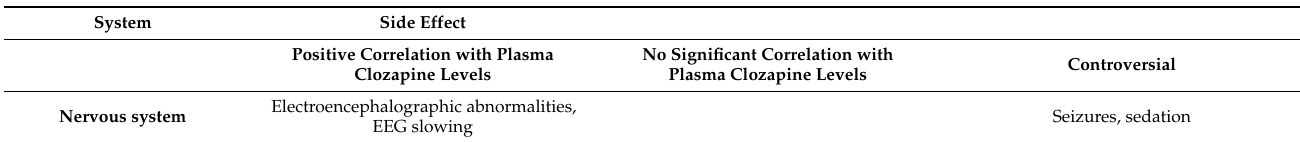
Table 8. Classification of side effects according to their relationship to plasma clozapine or norclozap- ine levels, based on current